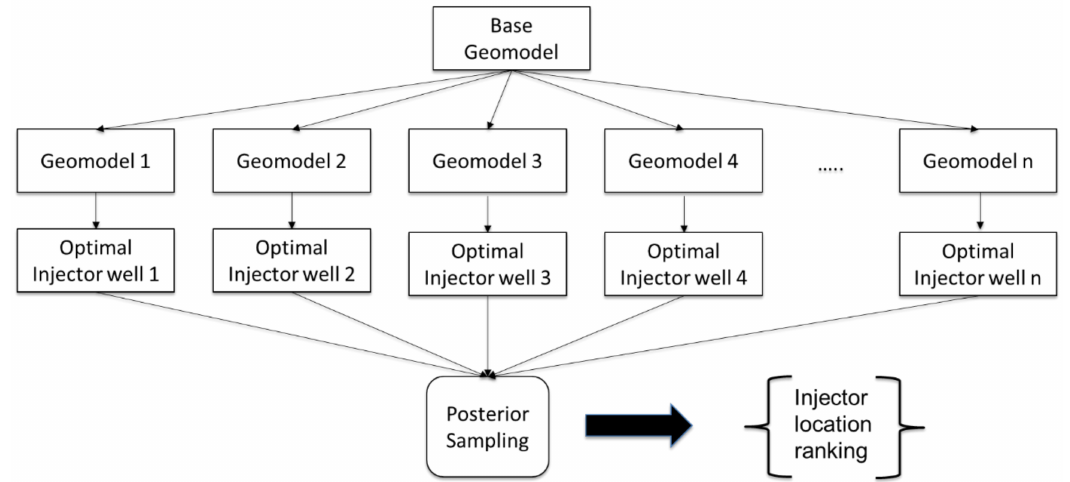
Figure 14. Illustration of the diversity of injection location options with multiple geomodels and the use of posterior sampling to efficiently rank each injector location across the geomodel